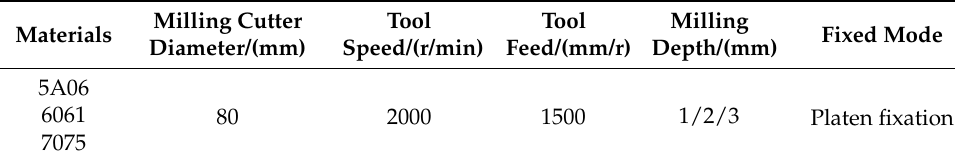
Figure 4. Aluminum alloy antenna milling site and finished product diagram.